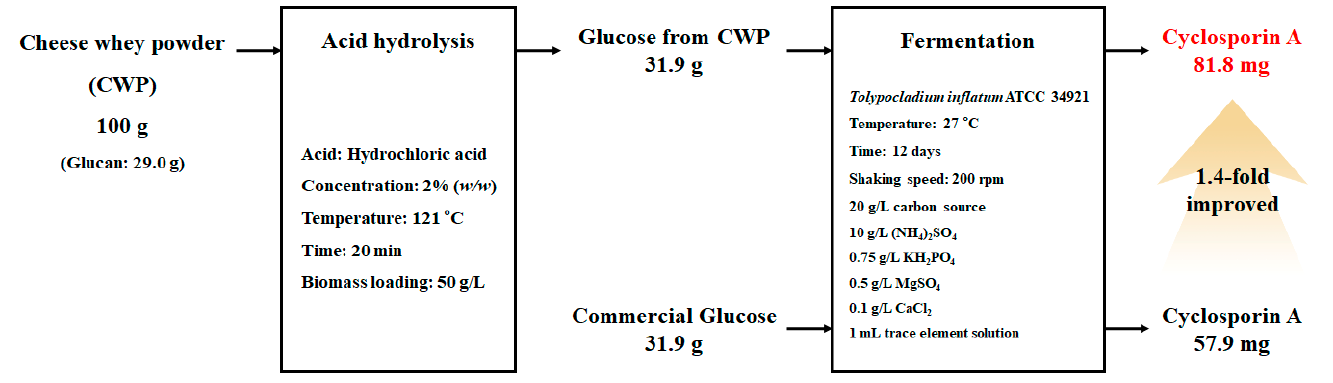
Figure 7. Mass balance of the overall process for cyclosporin production from cheese whey powder.